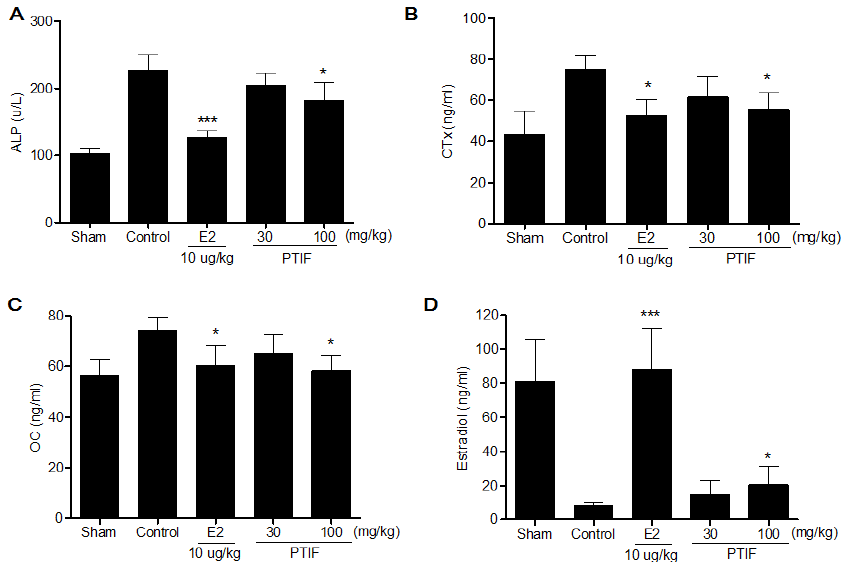
Figure 5. Effects of PTIF on serum alkaline phosphatase (ALP) ( A ), collagen type I (CTx) ( B ), osteocalcin (OC) ( C ) and estradiol ( D ) levels. Data are the mean ± SEM values ( n = 12 per group). * p < 0.05 and *** p < 0.001, significantly difference from the OVX-control